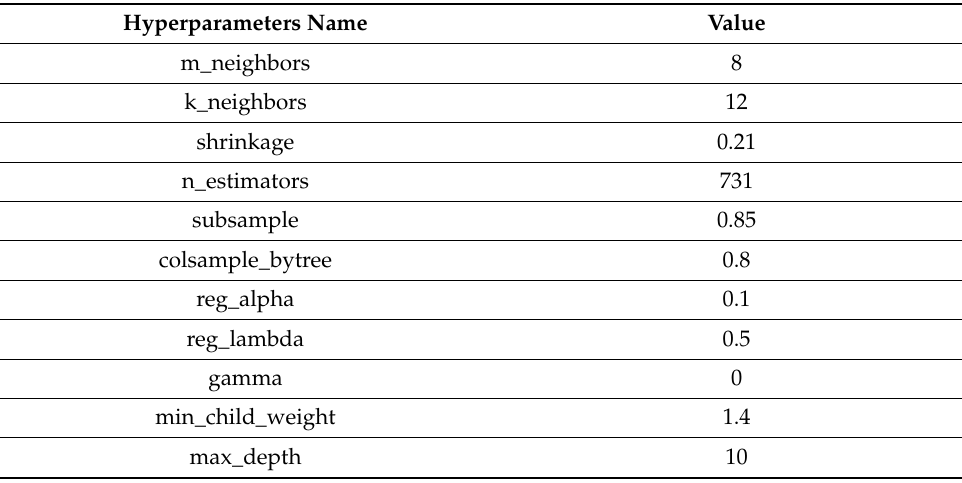
Table 4. The hyperparameters for GMM-SMOTE (excluding n_cluster) and XGBoost (excluding decision threshold) and their corresponding values used for the model. For the definition of the hyperparameters, readers are referred to WY21